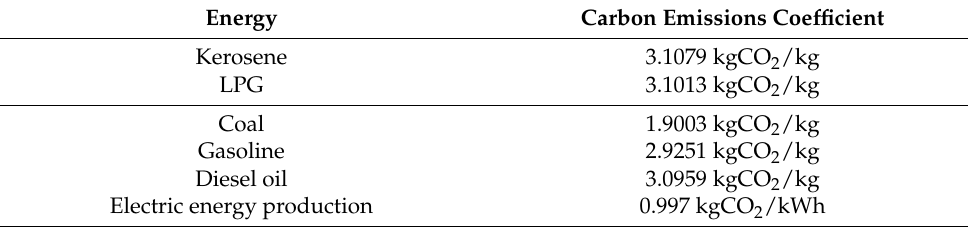
Table 3. The carbon emissions coefficient.